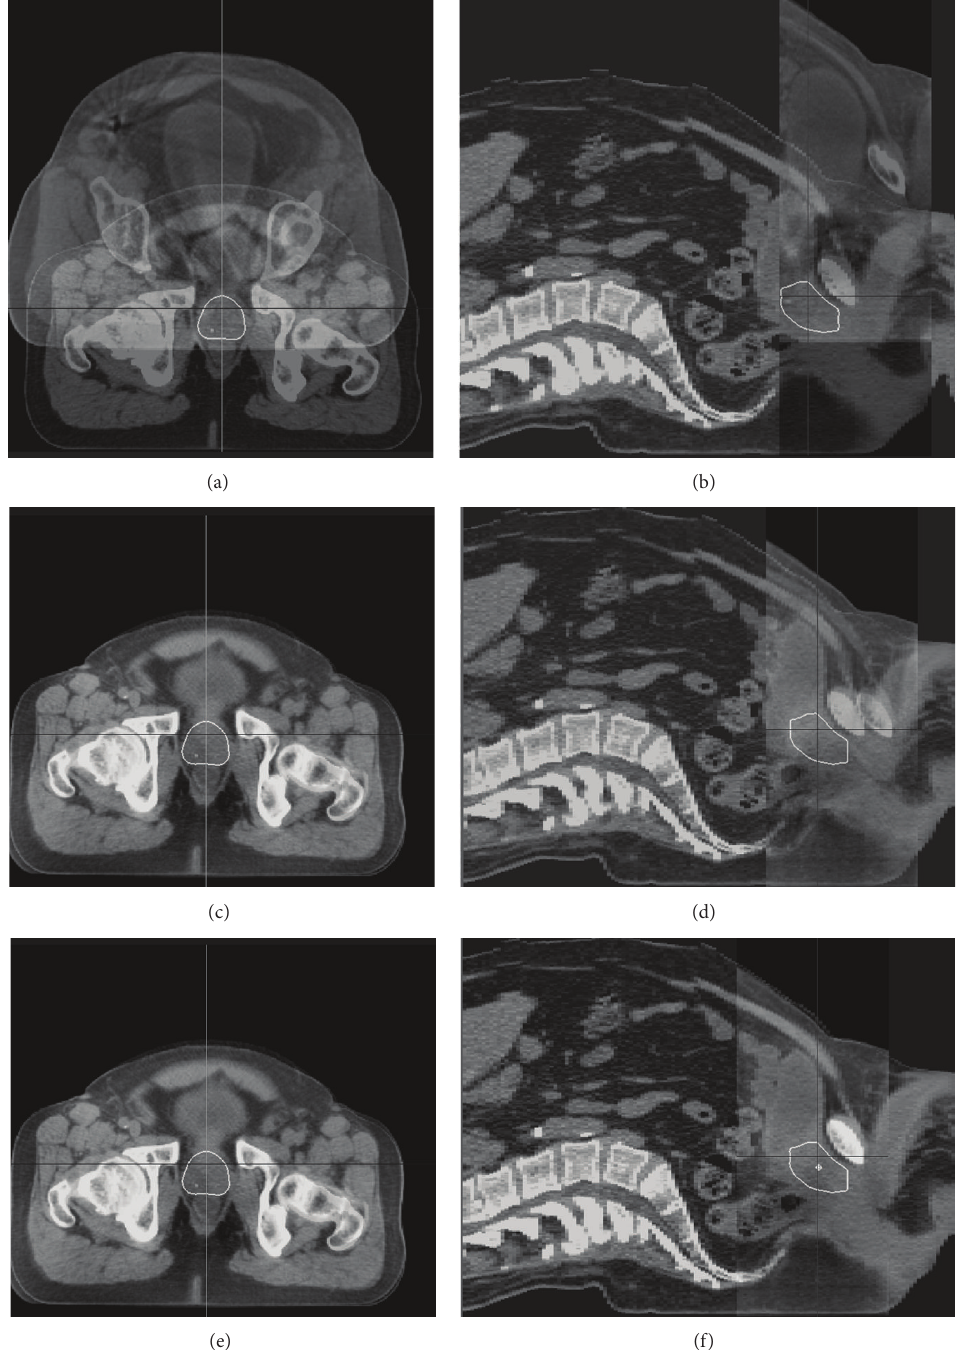
Figure 3: Multiscale registration of a pCT with a CBCT. The planning prostate segmentation is white. ((a), (b)) Blended axial and sagittal slices of unregistered images. ((c), (d)) Axial and sagittal slices of images registered via Step (1) . ((e), (f)) Axial and sagittal slices of images registered via mutual information in the prostate ROI (Step (3) ). In this example, there is little difference between the second and third steps.